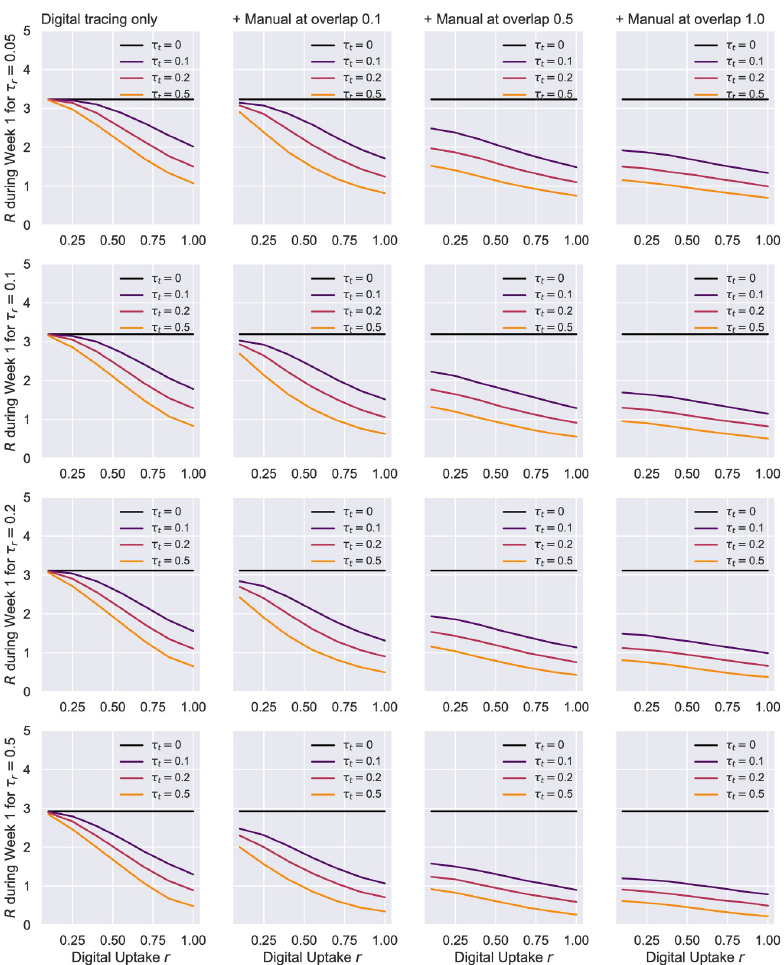
Fig 13. HK network—Uptake rate r against the effective reproduction number R . Suppression represents the difference to no tracing, i.e. τ = 0. The results here correspond to a Holme-Kim network with N = 1000, m = 10, p 4 = t 0.2, p a = 0.2, η = .001. On the left, we have a scenario in which only digital tracing was conducted, whereas the next columns represent simulations with a combination of digital tracing on a second network, and manual tracing over a third network with various overlaps: 0.1, 0.55, 1. The case with no contact tracing ( τ t = 0) is colored in black.